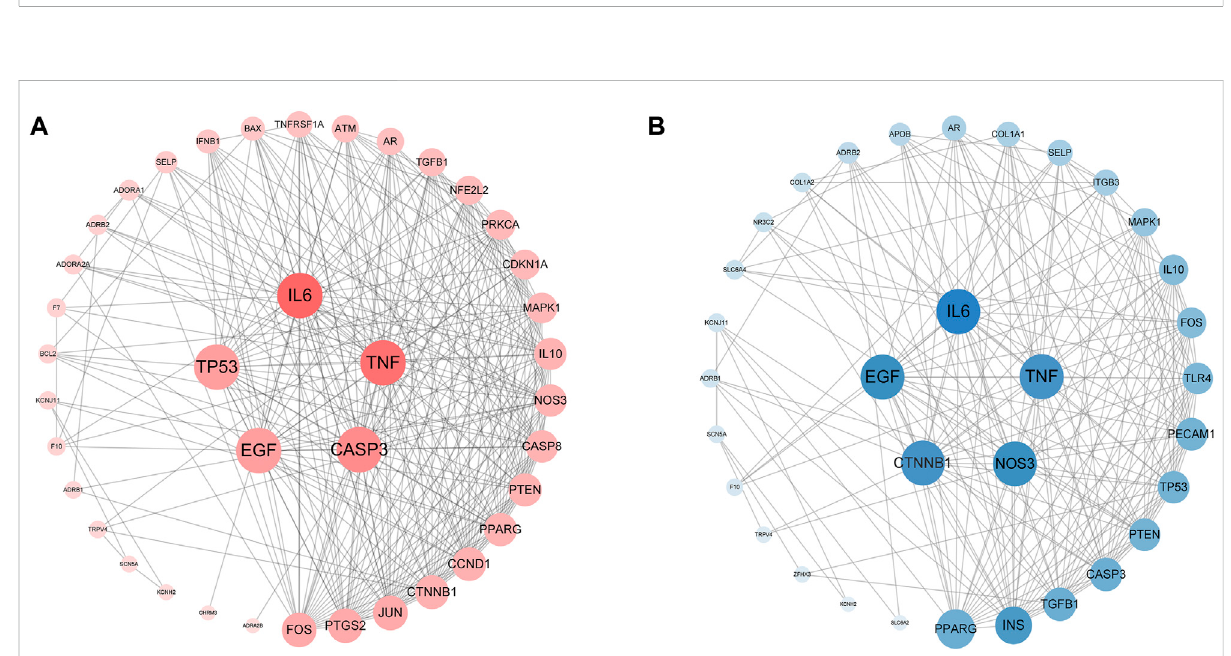
FIGURE 2 Venn diagram. (A) Purple stands for 159 targets of Cordyceps from TCMSP, blue stands for 526 targets of tachyarrhythmia, 40 in the central overlappingsectionareintersectingCordycepsandbradyarrhythmiatargets. (B) Purplestandsfor159targetsofCordycepsfromTCMSP,bluestands for 647 targets of tachyarrhythmia, 34 in the central overlapping section are intersecting Cordyceps and tachyarrhythmia targets.